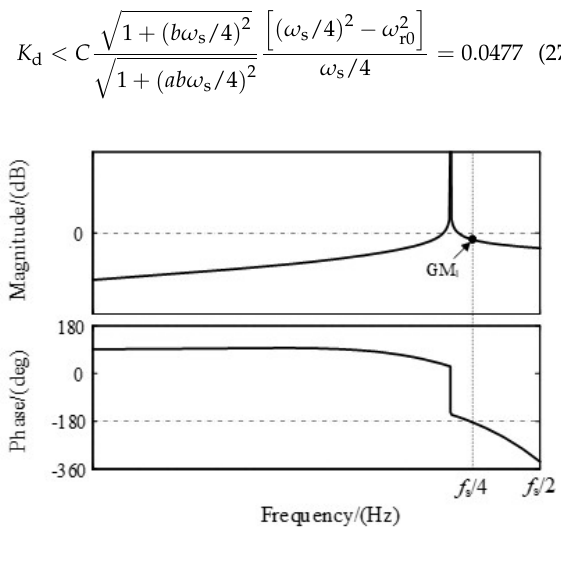
Fig. 13. Bode Diagram of φ ( s ) .